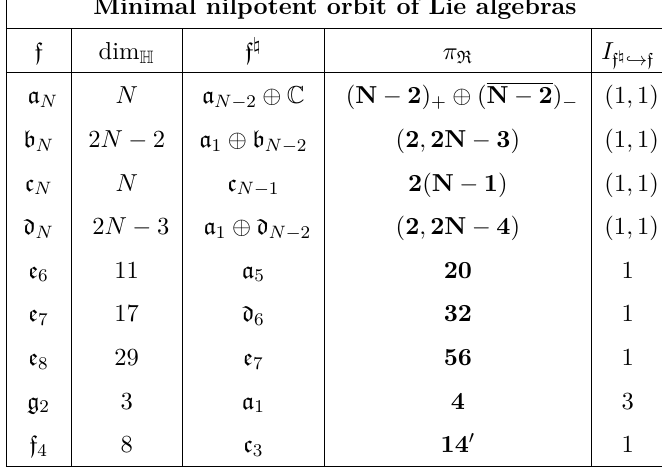
Table 5. For the convenience of the reader, we summarize the properties of minimal nilpotent orbit for all classical and exceptional Lie algebras which appear copiously as elementary slices on the HB. This table is almost verbatim taken from [97], for more info on the entries of this table please consult appendix